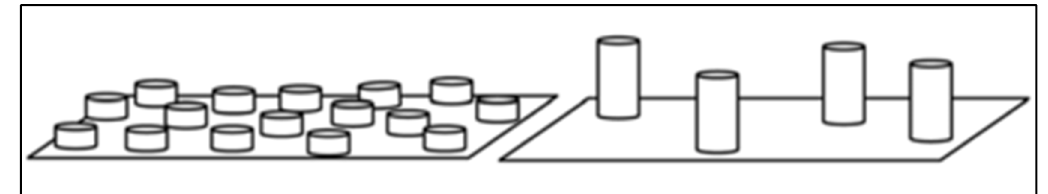
Figure 7. The Telephone Pole Problem. Both of these surfaces have the same roughness density, but on the left roughness density is partitioned into sixteen elements, whereas on the right, it is partitioned into four objects four times the height. Under the shear stress partitioning model of Raupach et al. [121], both surfaces experience the same horizontal flux, although intuitively this is not an accurate representation of physical reality (from [58] (p. 3)).